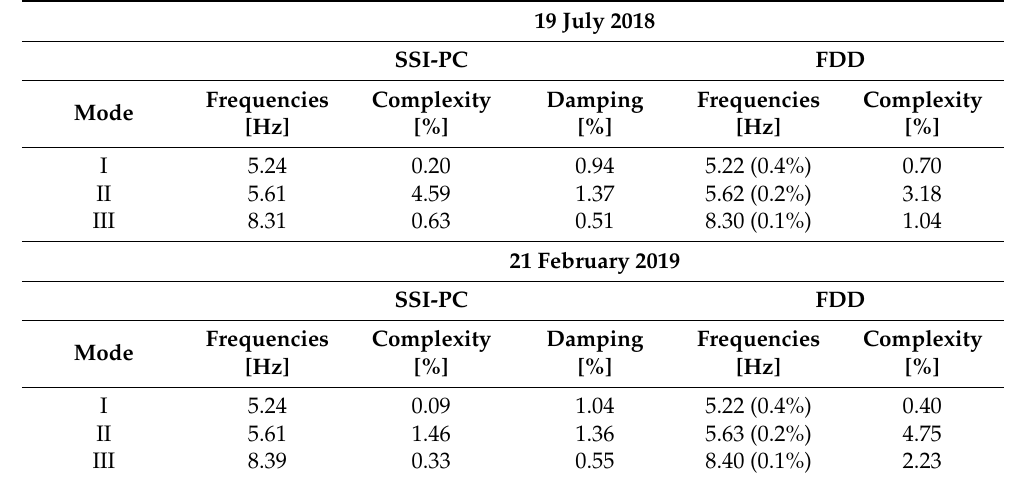
Table 1. Frequencies, complexities and dampings estimated by FDD and SSI-PC methods (the per- centage in brackets indicates the absolute error taking as reference the results of the SSI-PC